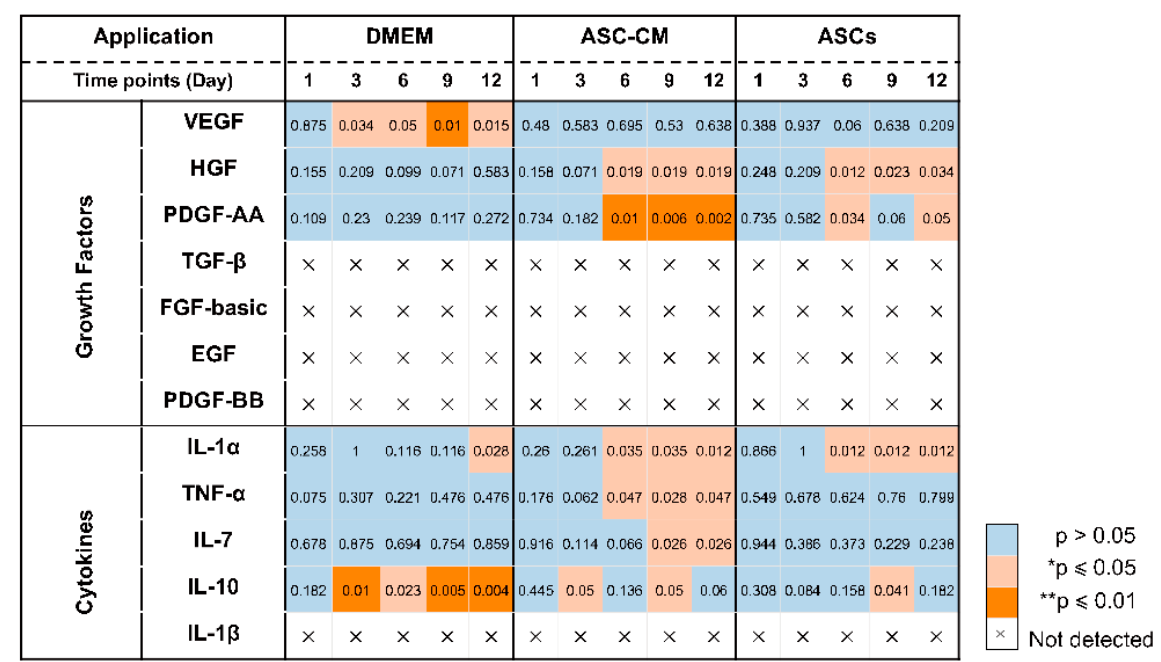
Figure 10. Visualization of statistically significant differences between treated samples and controls in wound extracts.